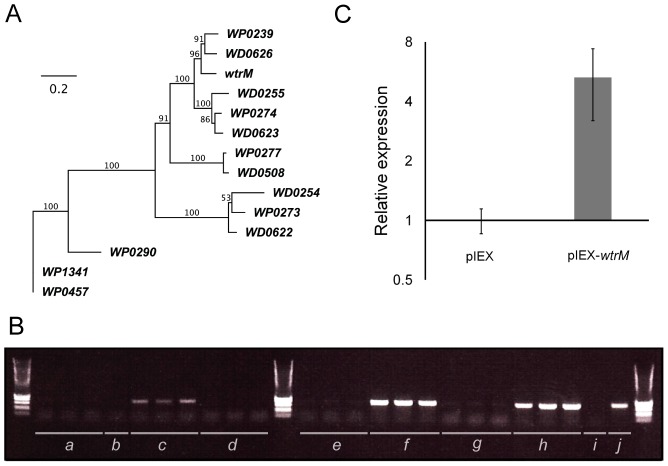
Analysis of transcription factor wtrM.

A. Phylogenetic tree of Wolbachia transcriptional regulator (wtr) genes. An unrooted maximum likelihood phylogenetic tree, constructed using PHYLIP, of transcriptional regulator genes in the wPip and wMel genomes from amino acid alignments. Bootstrap percentages for 100 trees are shown for each node. B. Transcription of wtrM in Culex mosquitoes. Expression of wtrM was validated by RNA extraction and PCR on the cDNA using primers internal to the open reading frame of the gene. There is no transcription of wtrM detectable in control untransfected ovaries (a) or carcasses (b) from Pel. There is a high level of transcription of wtrM in ovaries from untransfected Mol mosquitoes (c) but not in carcasses (d). In Pel mosquitoes transfected with wtrM by injection into the thorax (e, f) there is no transcription detected in ovaries (e) but strong expression in carcasses (f). Transfection of wtrM into the abdomen of Pel mosquitoes produced no detectable transcription in ovaries (g) but transcription readily detected in carcasses (h). An untransfected whole female of Pel (i) and Mol (j) are also shown. C. CPIJ005623 upregulation in transfected Culex females. Transcription of the Culex gene CPIJ005623 in Pel females transfected with the wPipMol gene wtrM, compared to Pel females transfected with the same plasmid but containing no insert. Difference was significant at p<0.01 using a Wilcoxon rank sum test.